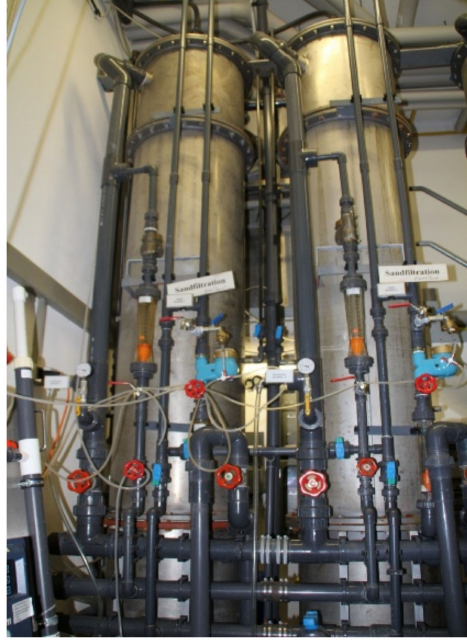
Figure 2. Pilot plant